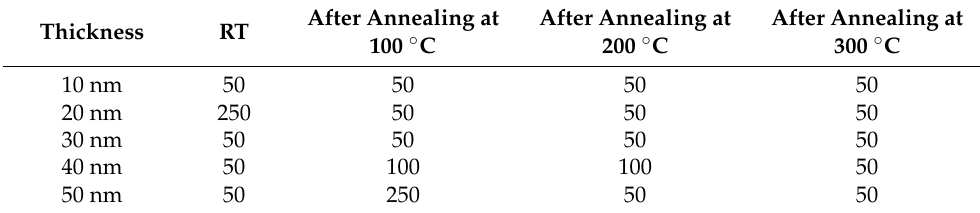
Figure 6. Maximum alternate-current magnetic susceptibility for the CoFeBY films. Table 2. Optimal resonance frequency for films of various thicknesses.